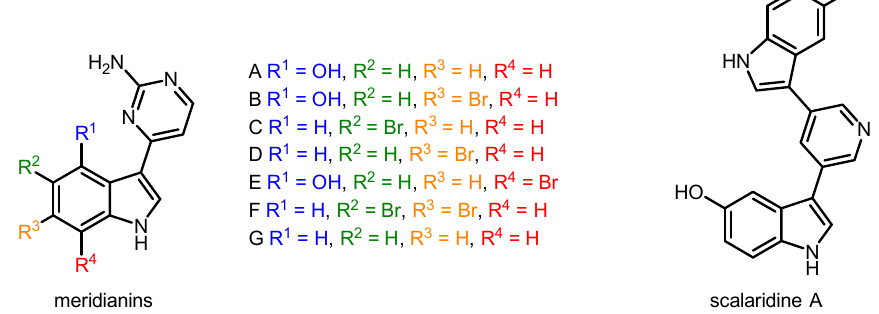
Figure 1. Indole alkaloids meridianins A–G from tunicate Aplidium meridianum and scalaridine A from marine sponge Scalarispongia sp.